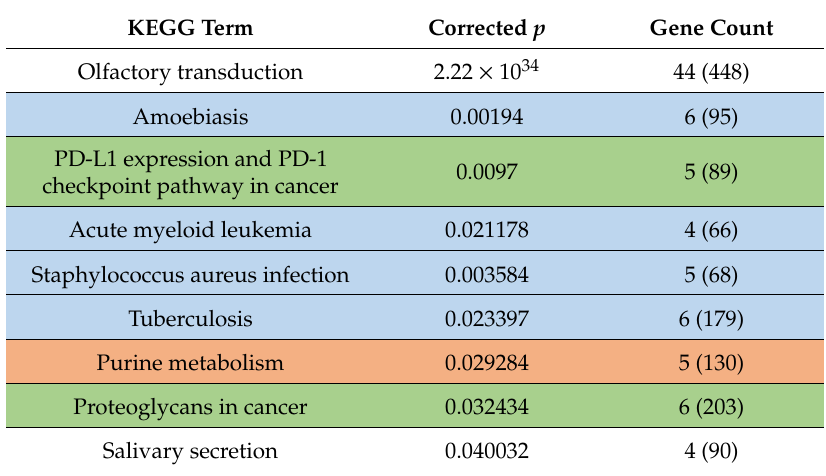
Table 1. Enriched gene ontology terms among the candidate genes under selection 1